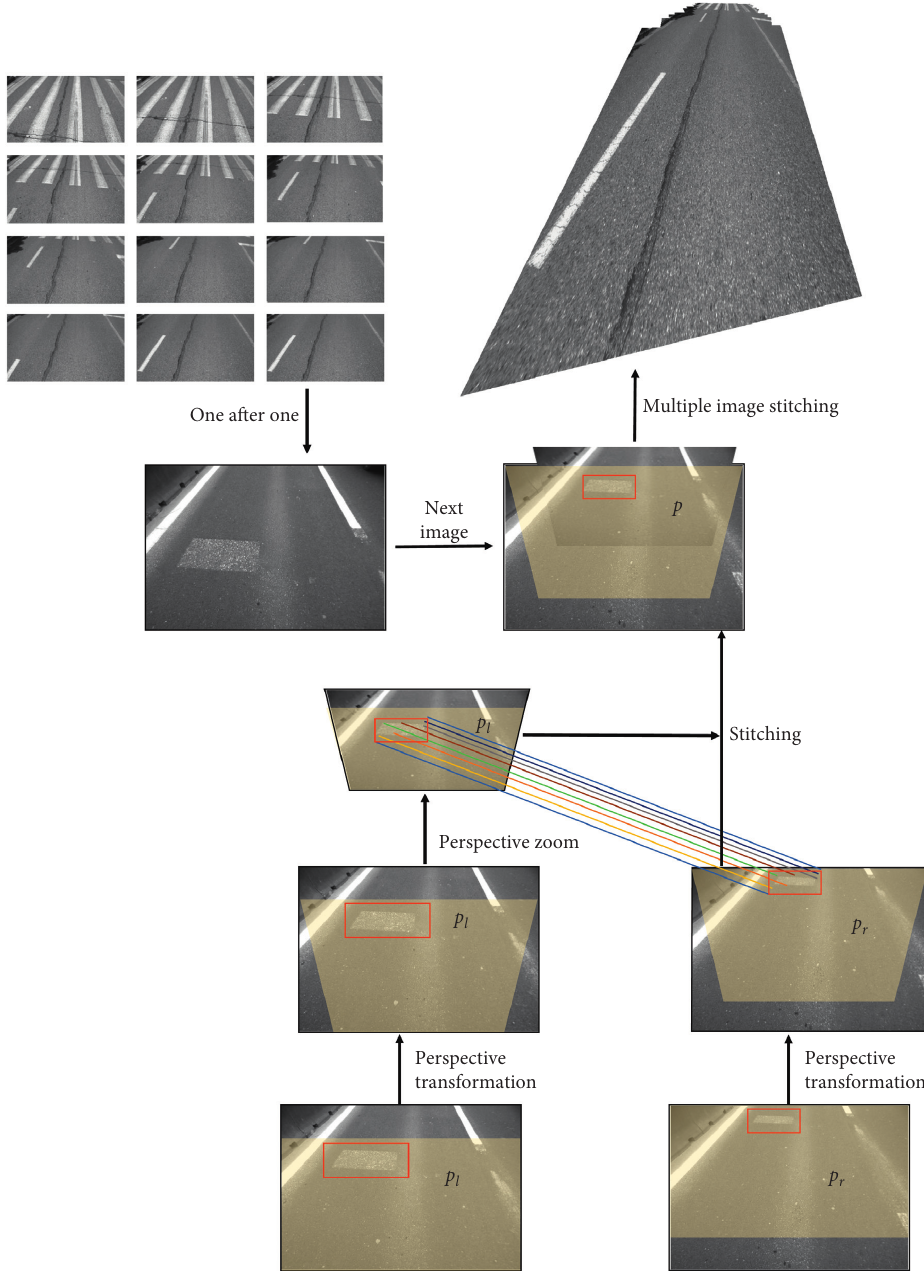
Figure 13: Flow chart of the image stitching